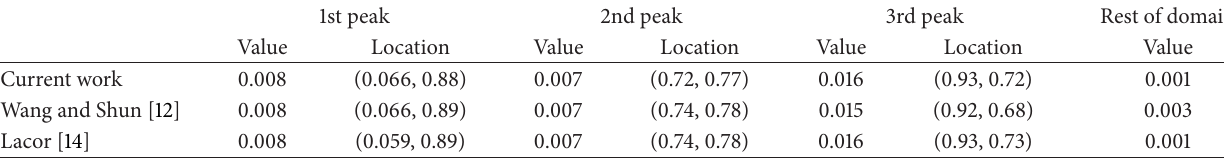
Table 2: Standard deviation of vertical velocity component (peaks from left to right).